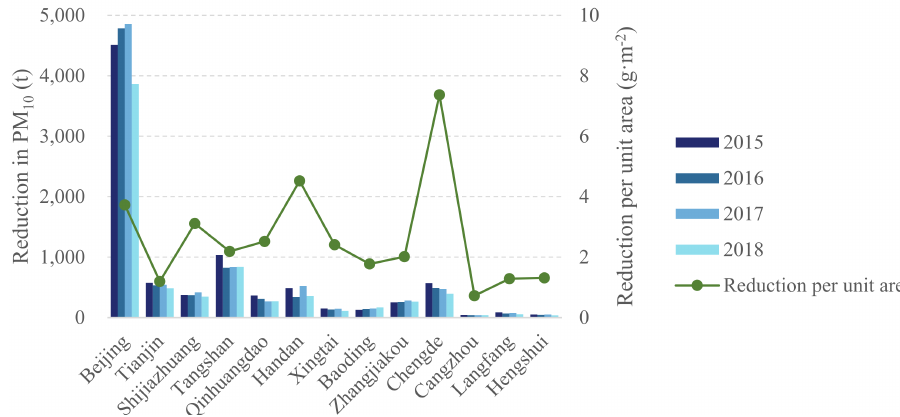
Figure 13. PM 10 removal of each city at the built-up area scale from 2015 to